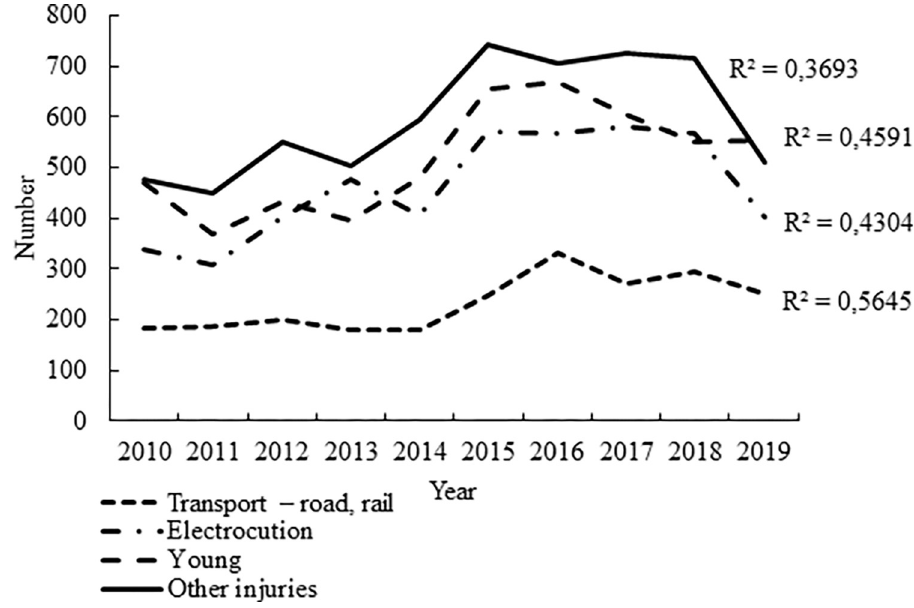
Fig 2. Numbers of raptors admitted to rescue centres in the Czech Republic in the period from 2010 to 2019 for the most common reasons for admission. https://doi.org/10.1371/journal.pone.0279501.g002 The outcomes for raptors admitted to rescue centres are given in Table 6. It proved possible to release 42.45% of admitted raptors back into the wild. Of them, 91.05% of raptors were released using the hard-release method. The soft-release method was used less often. More than a third (39.97%) of admitted raptors died or had to be euthanized at rescue centres. Con- sidering the most common reasons for admission, the highest mortality rate was found in birds admitted due to electric shock injuries (81.25% of admitted raptors died or had to be euthanized). In contrast, only 5.81% of admitted young died or had to be euthanized (Table 7). The length of time spent at rescue centres differed (p < 0.05) in raptors with various out- comes (Fig 3). The raptors that were subsequently released using the hard-release method (median 30 days, range 1–1,442 days) and the soft-release method (median 28 days, range 1–151 days) spent the longest time at rescue centres. The length of time there did not affect release type (p > 0.05). The raptors that died or had to be euthanized at rescue centres spent usually only a couple of days there (median 2 days, range 1–2,358 days).